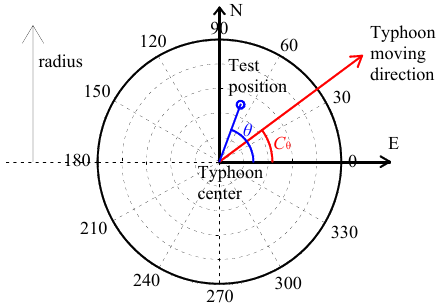
Figure 2. Definition of the flow direction and polar coordinate.